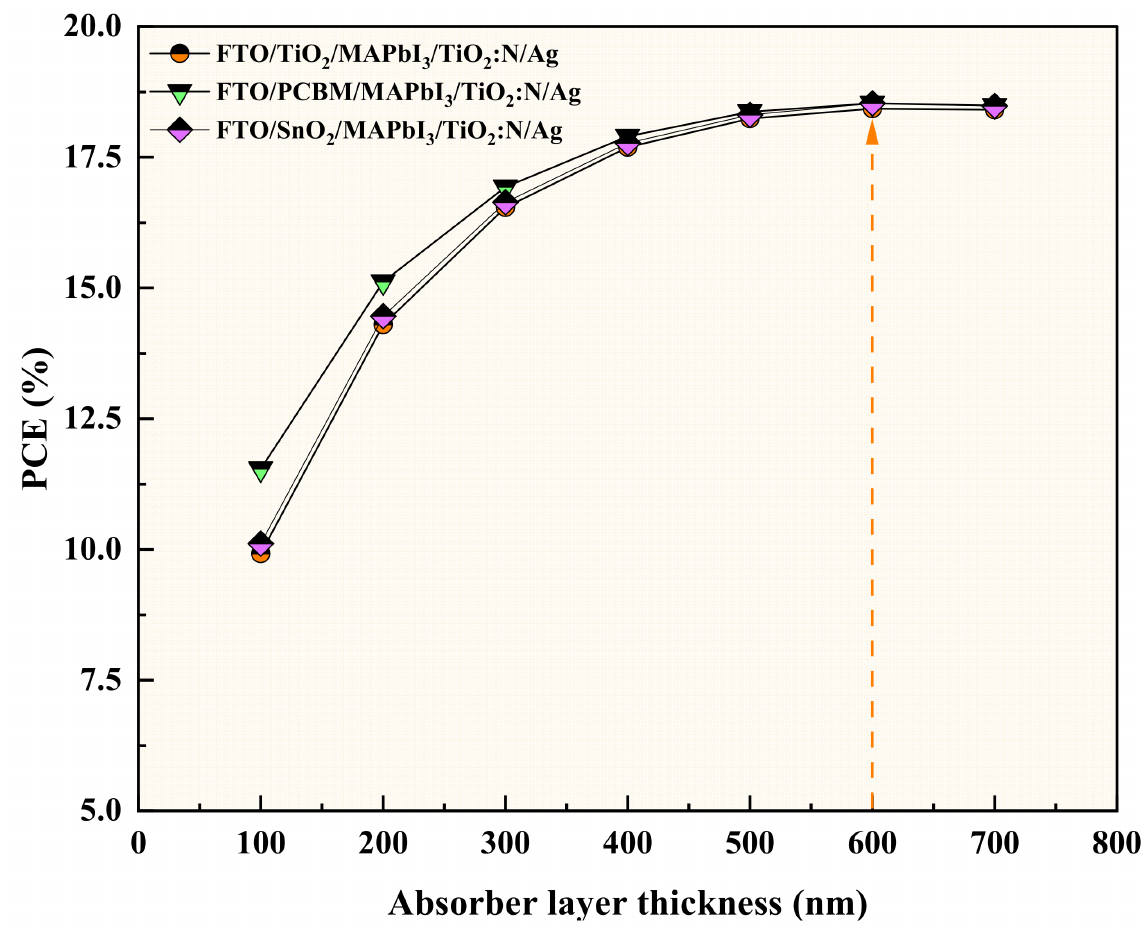
Figure 5. Efficiency curves for a gradient in absorber layer thickness indicating the threshold limit of 600